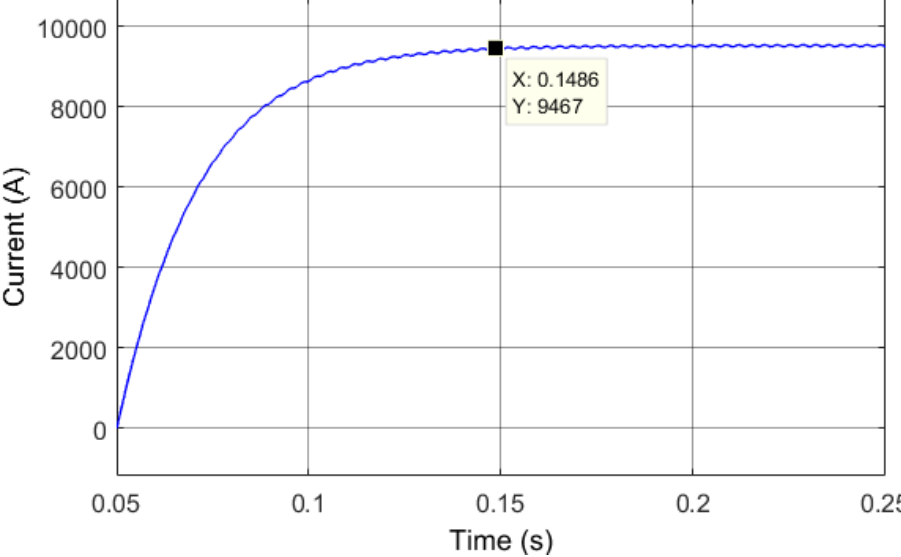
Figure 8. Test model simulation results.